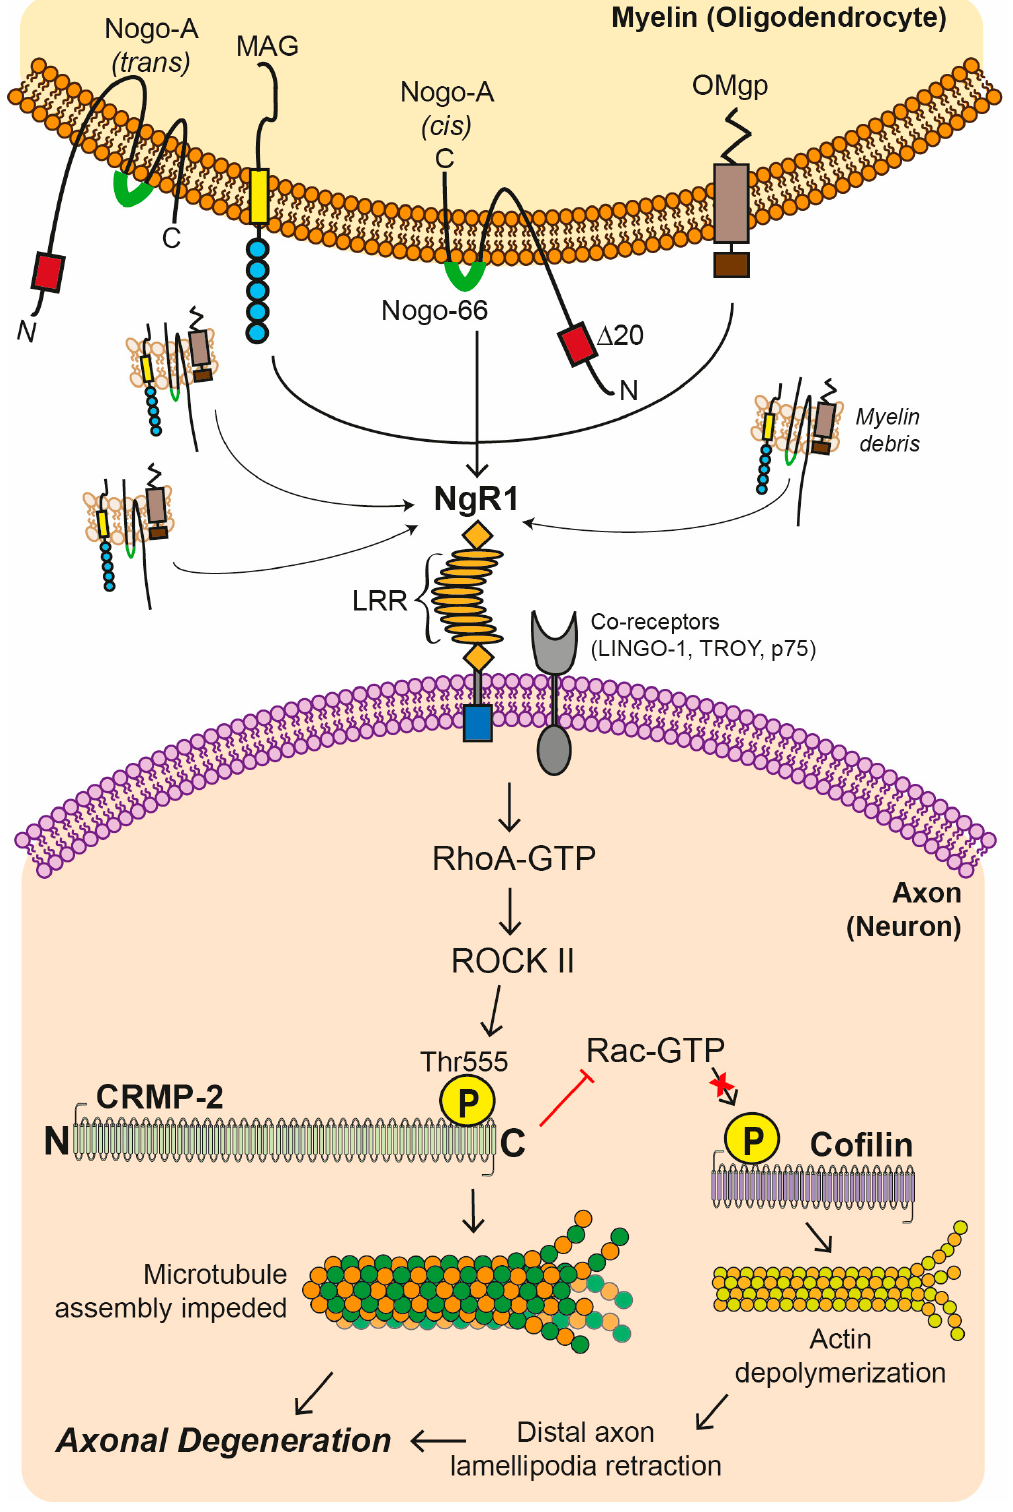
Figure 2. Nogo receptor 1 (NgR1)-dependent signaling cascade.